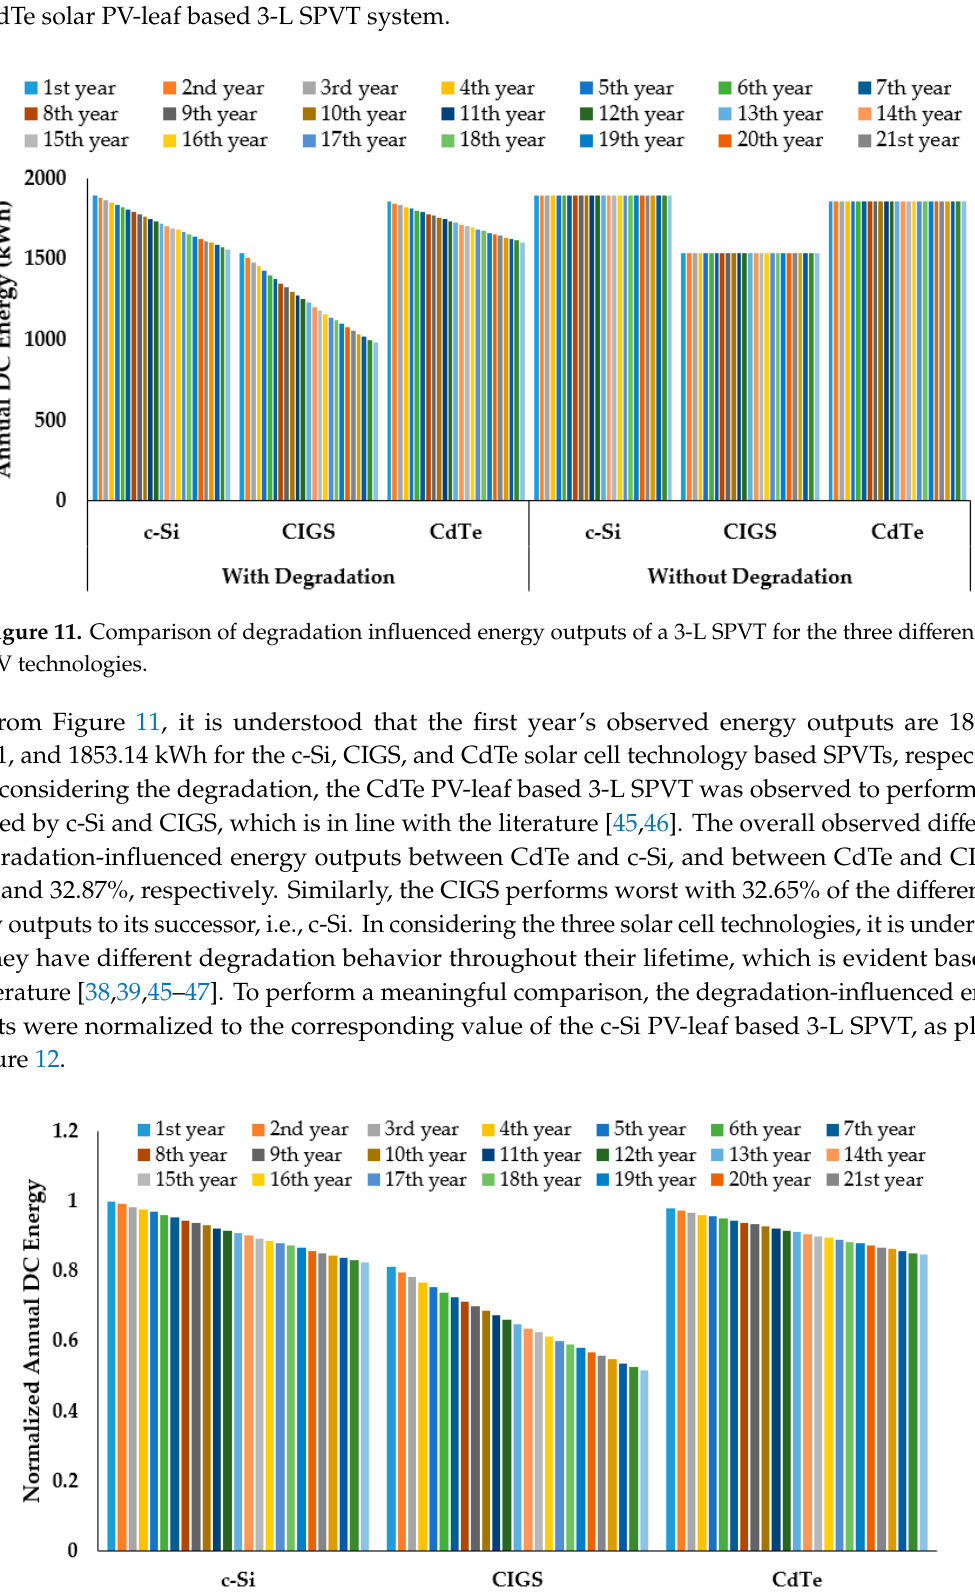
Figure 12. Comparison of normalized degradation influenced energy outputs of a 3-L SPVT for the three different PV technologies.